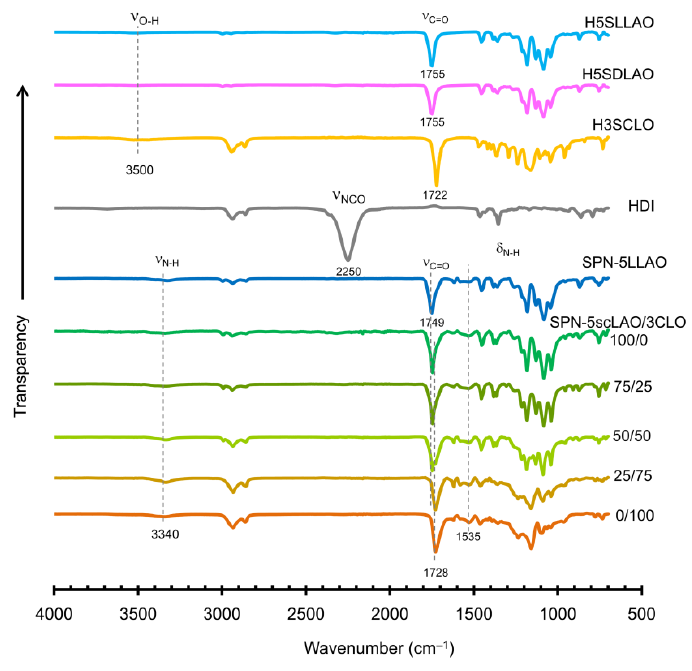
Figure 3. FT-IR spectra of H5SLLAO, H5SDLAO, H3SCLO, HDI, SPN-5LLAO and SPN-5scLAO/3CLOs (100/0, 75/25, 50/50, 25/75 and 0/100).